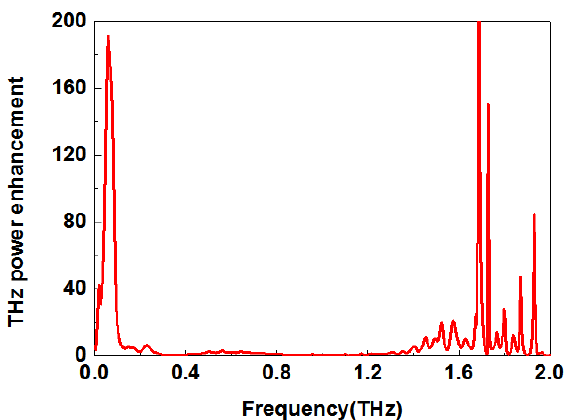
Figure 7. THz power enhancement of the proposed PCA compared to the conventional PCA at different frequencies.